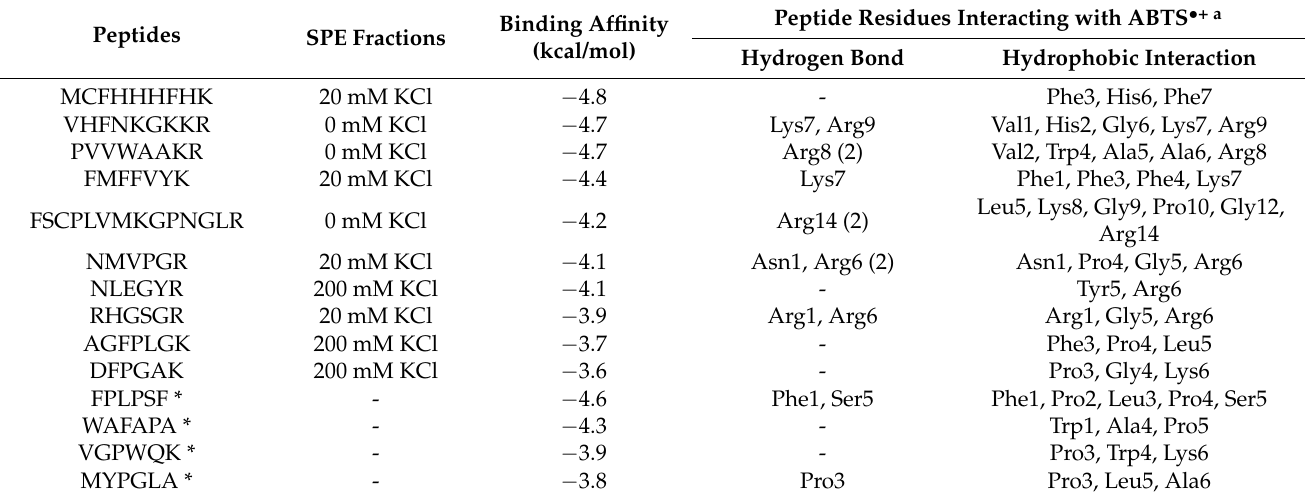
Table 3. Binding affinities and types of interactions between 10 corn silk peptides and ABTS • + , in comparison with four reference